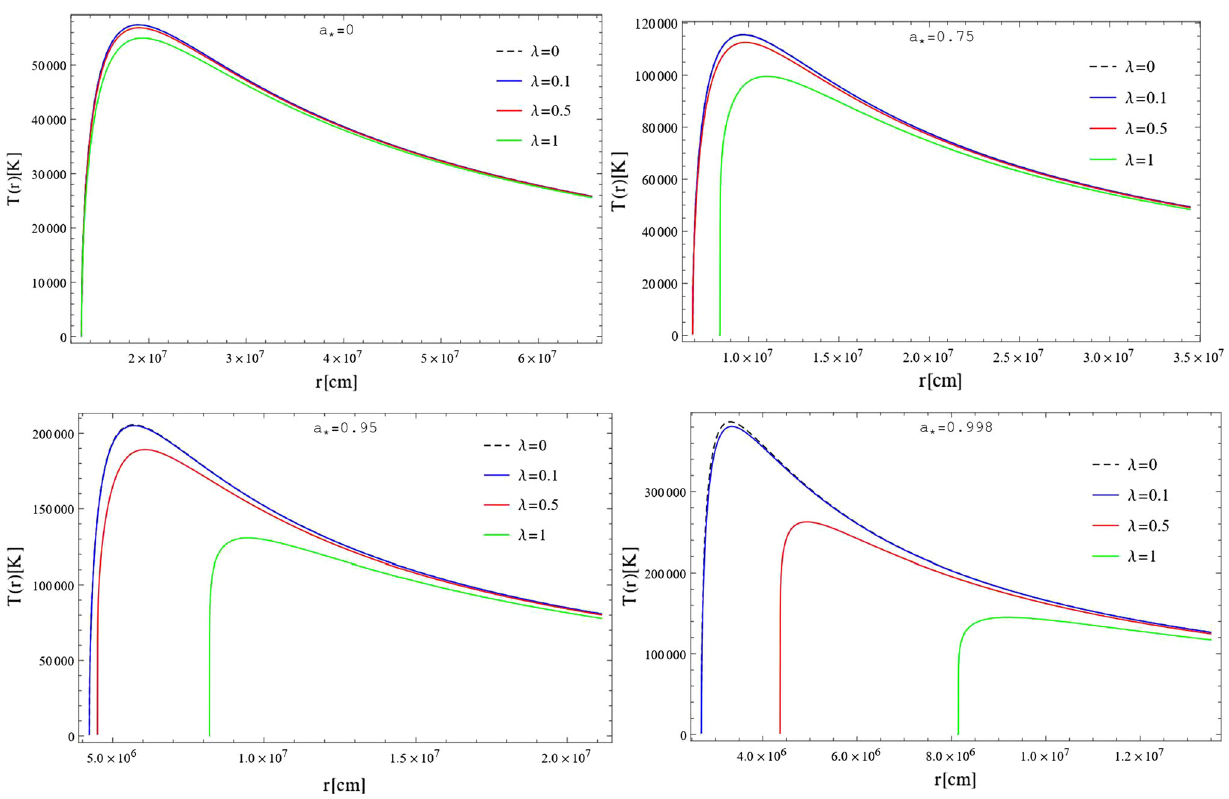
Fig. 3 Temperature distribution T ( r ) as a function of the radial coordinate r (in cm) of the accretion disk for a RDSWH plotted for different values of λ and compared with the Kerr